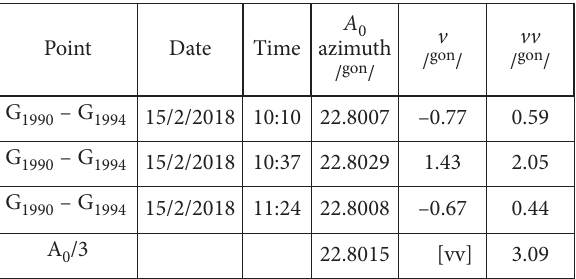
Table 9. Recorded A 0 azimuths and corrections